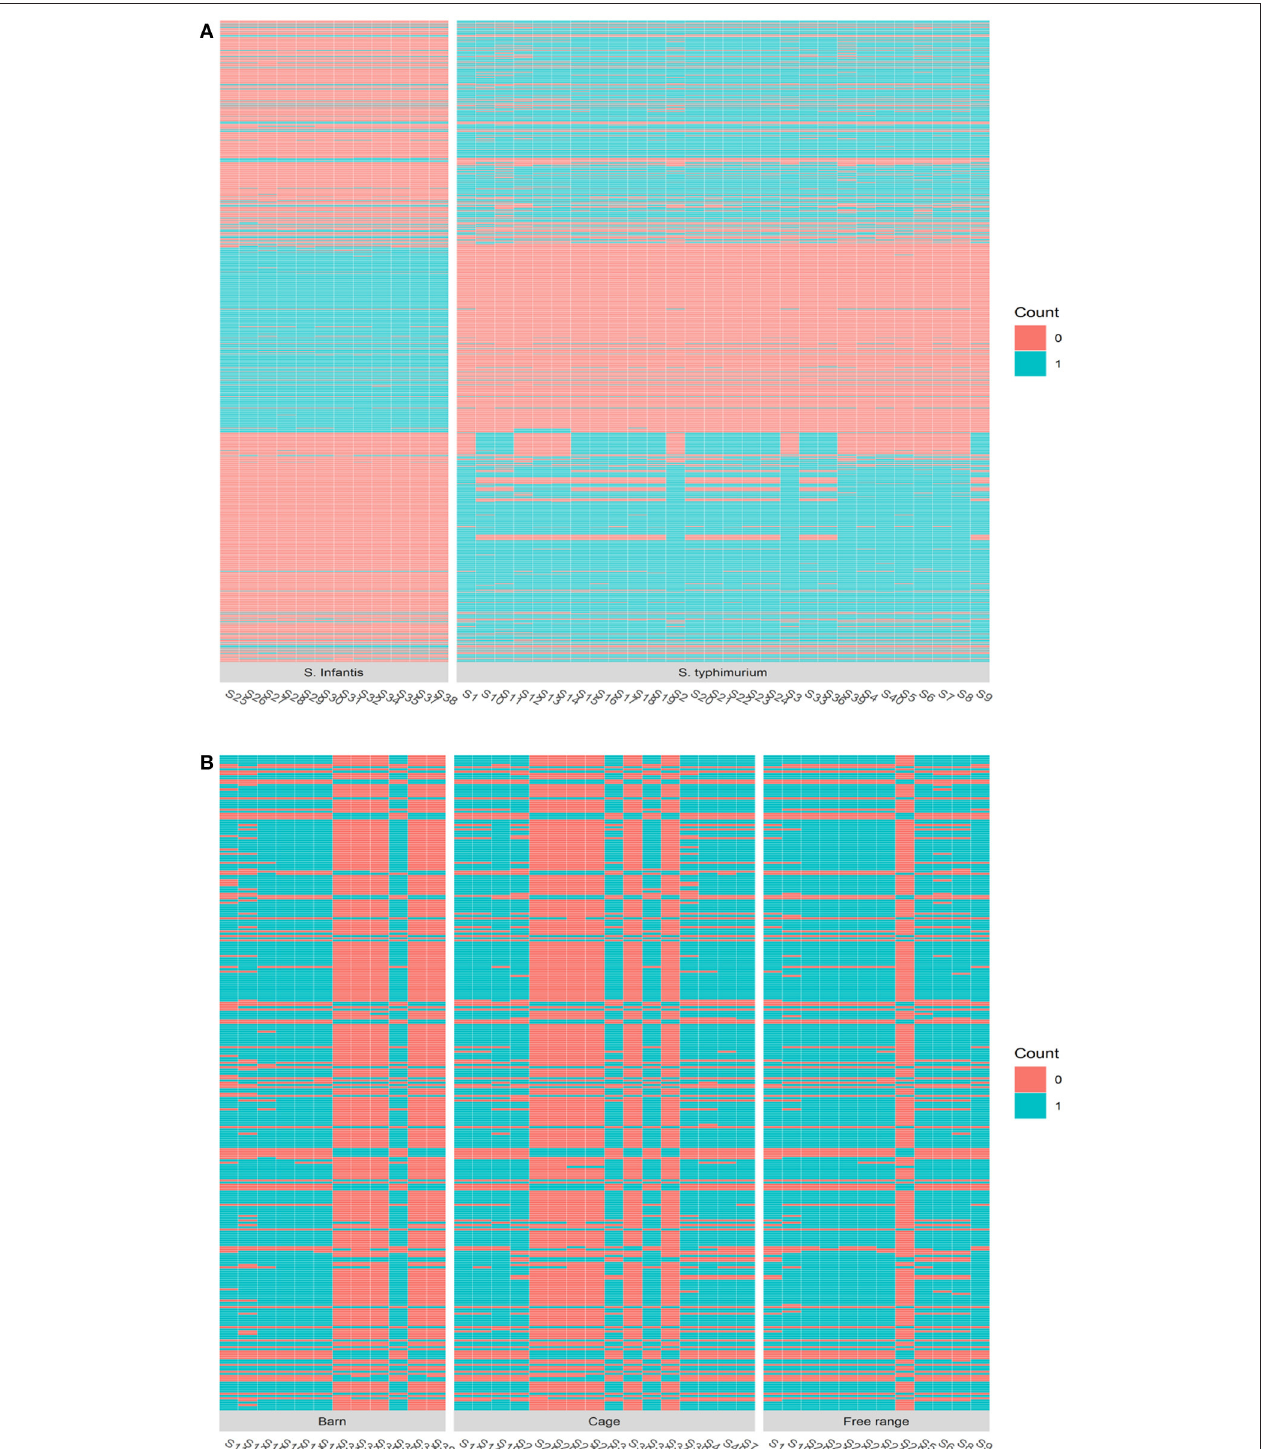
FIGURE 4 | The heatmap of the genomic composition comparison by different factors. (A) The heatmap comparing Salmonella Infantis and Salmonella Typhimurium serotypes on the genes identified to be differentially associated with the serotypic difference. (B) The heatmap comparing different egg production systems on the genes identified to be differentially associated with barn, cage, and free-range production